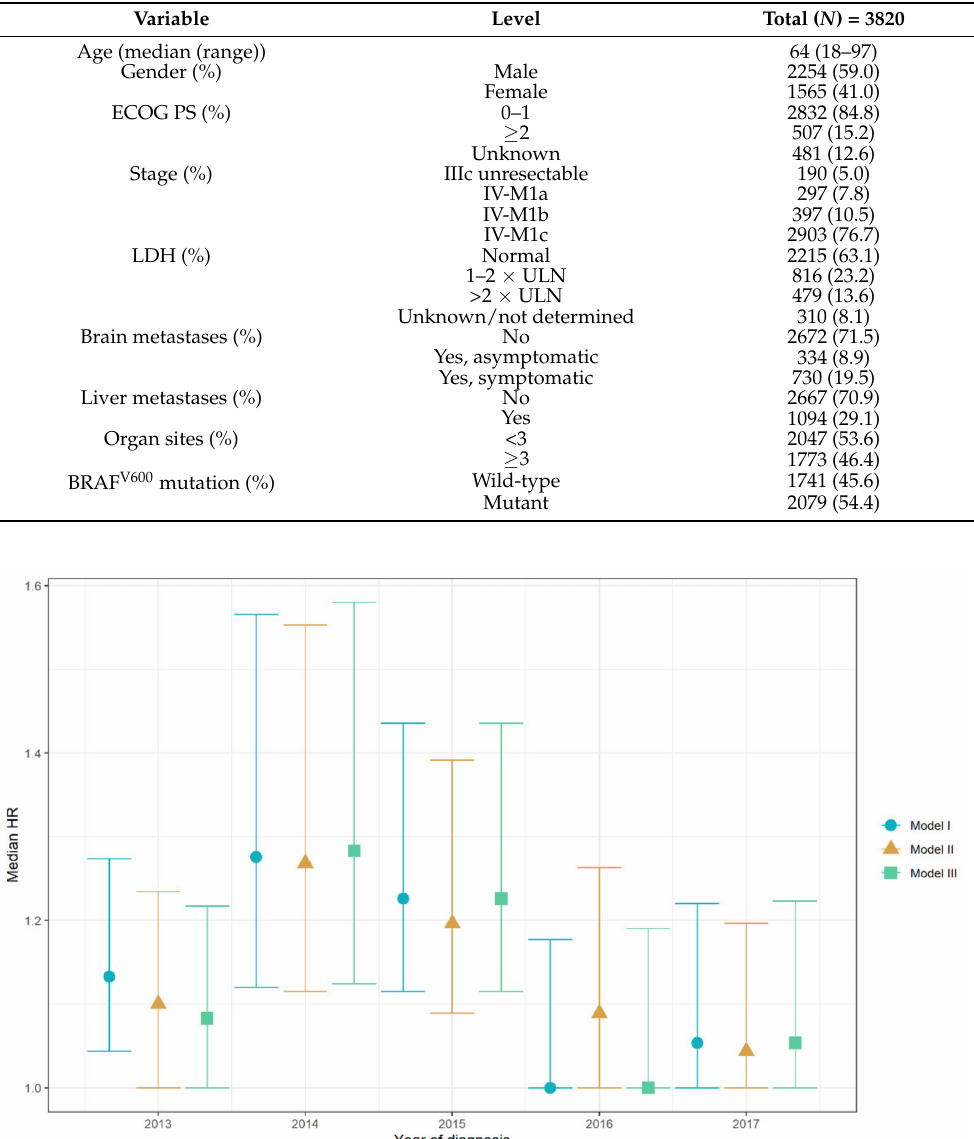
Figure 1. Hospital variation in 2-year survival probabilities expressed as mHRs in three Cox frailty models with gender, age at diagnosis, ECOG PS, LDH levels, number of organ sites, liver metastases, brain metastases, and BRAF mutational status as covariates and year of diagnosis as a factor. Intervals represent 95% confidence intervals of the mHRs. A mHR of 1.00 means that no center variation is present. The larger the mHRs, the larger the variation in 2-year probabilities between centers. The figure shows that significant variation in 2-year survival probabilities was significant between 2013 and 2015 and not significant in 2016 and